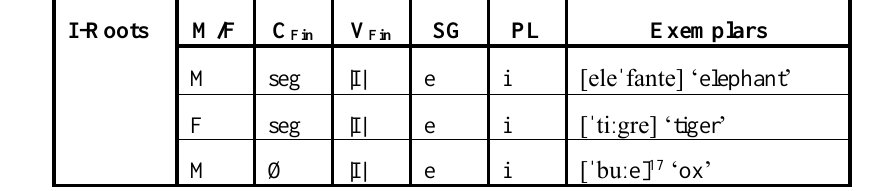
Table 7. Roots with final floating element